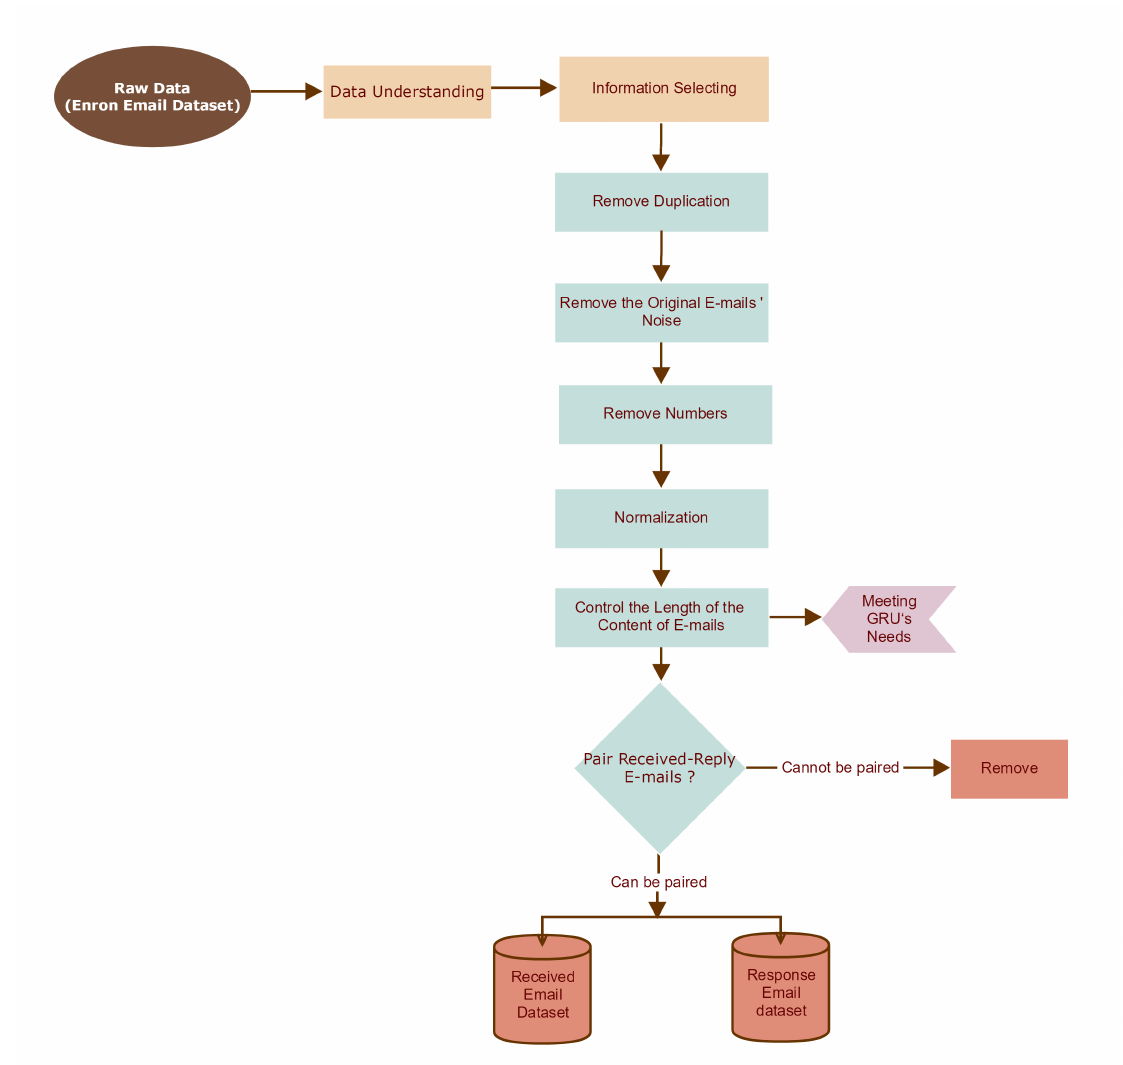
Figure 5. Data processing